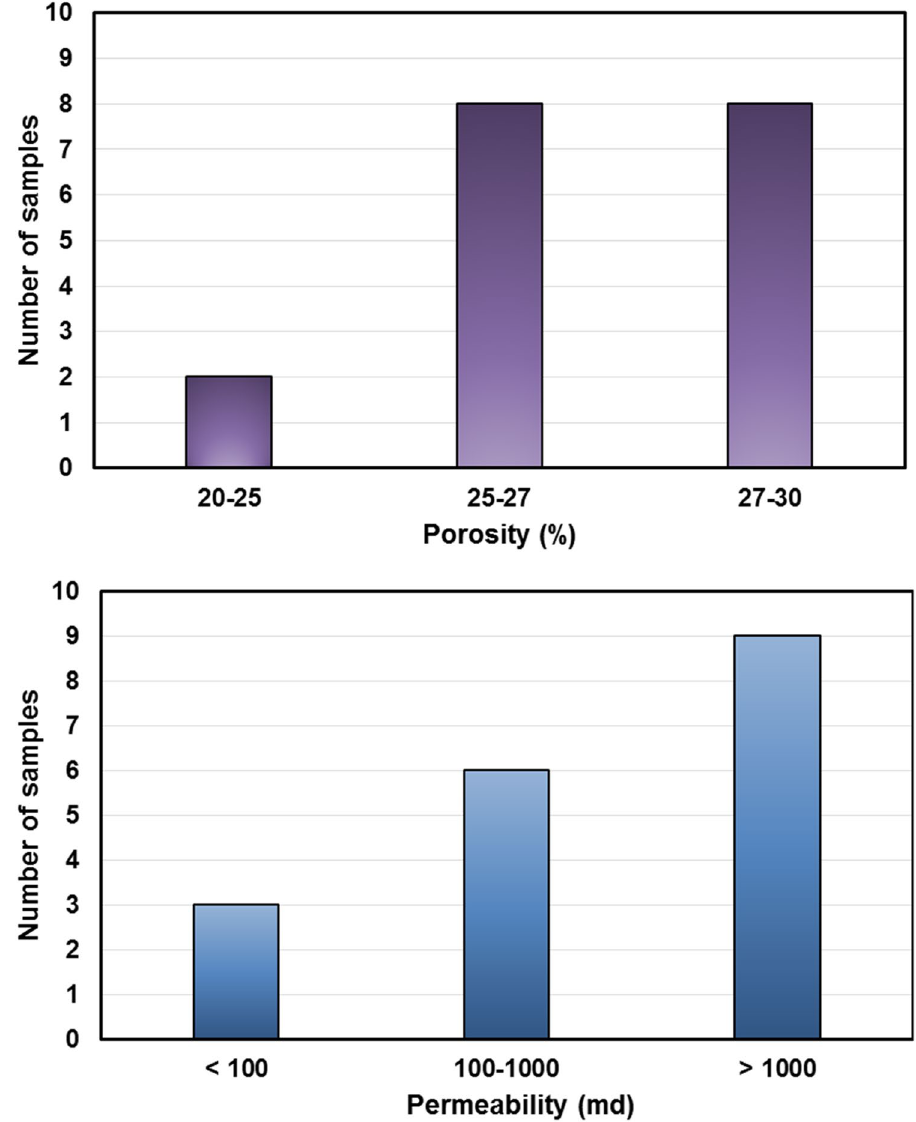
Fig. 4 Histograms illustrating the variation in the measured porosity and permeability